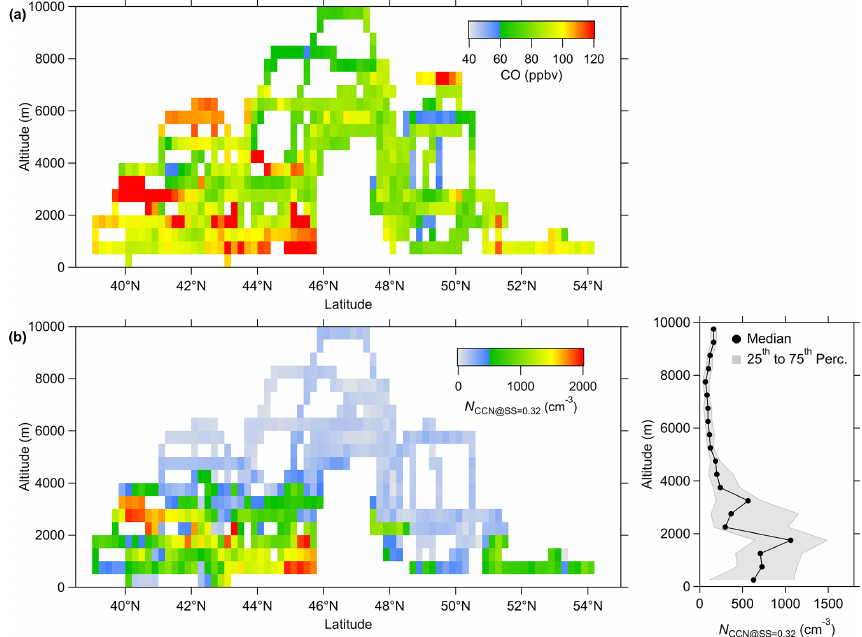
Figure 12. Vertical and latitudinal distribution observed during the EMeRGe IOP of (a) CO mixing ratios and (b) CCN number concentration at a supersaturation ( S ) of 0.32% (except for E-EU-04, due to instrumental failure). The CCN curtain plot on the bottom left is made with latitude- (0.2 ◦ ) and altitude-binned (500m) CCN number concentrations. On the right, the median vertical N CCN ( S = 0 . 32 %) profile is represented by a solid black line and the interquartile range by a grey-shaded area. CCN data are standard temperature and pressure (STP)